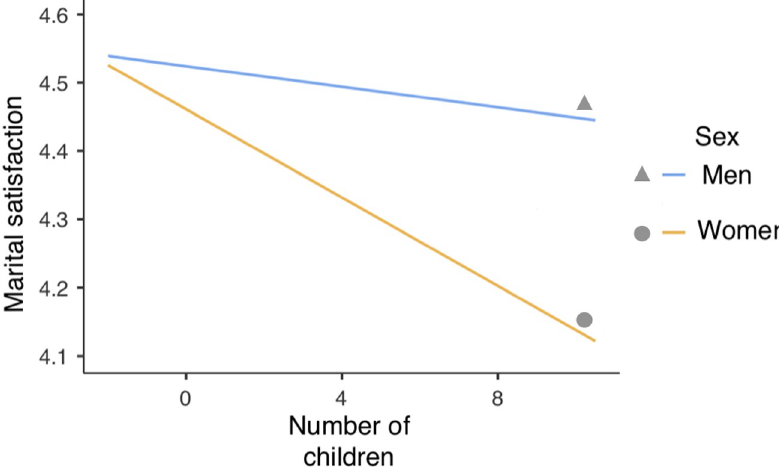
Fig 3. Interaction of the number of children and religiosity in relation to marital satisfaction (MRQ).